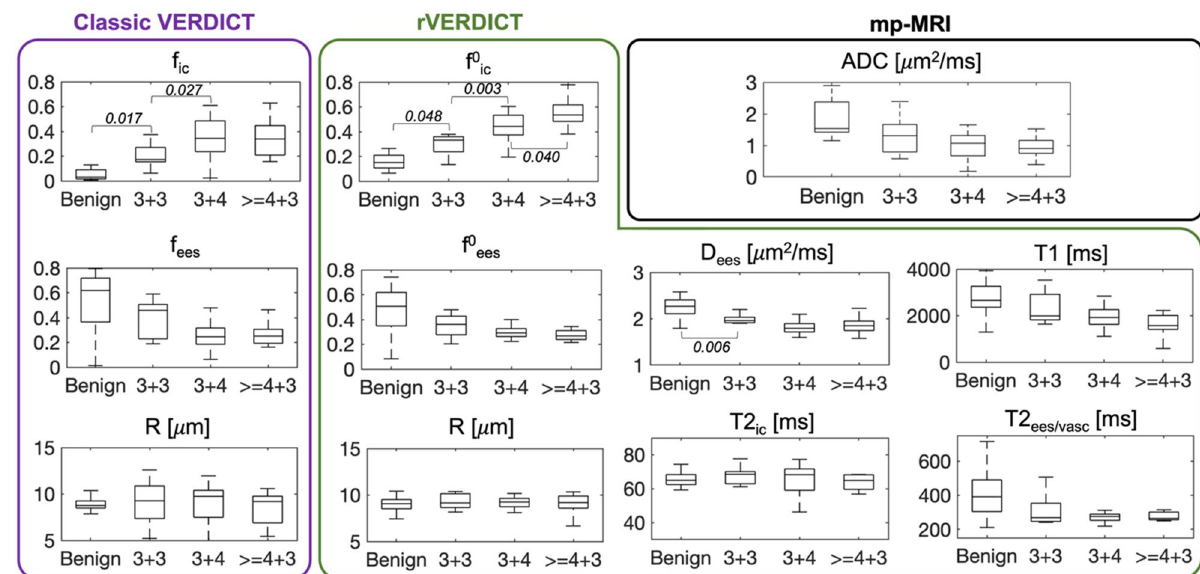
Figure 6. Box-and-whisker plots of the classic VERDICT, rVERDICT parameters and ADC from mp-MRI as a function of the Gleason grade groups. Only the differences with Bonferroni corrected p < 0.05 are considered significant and the corresponding p values